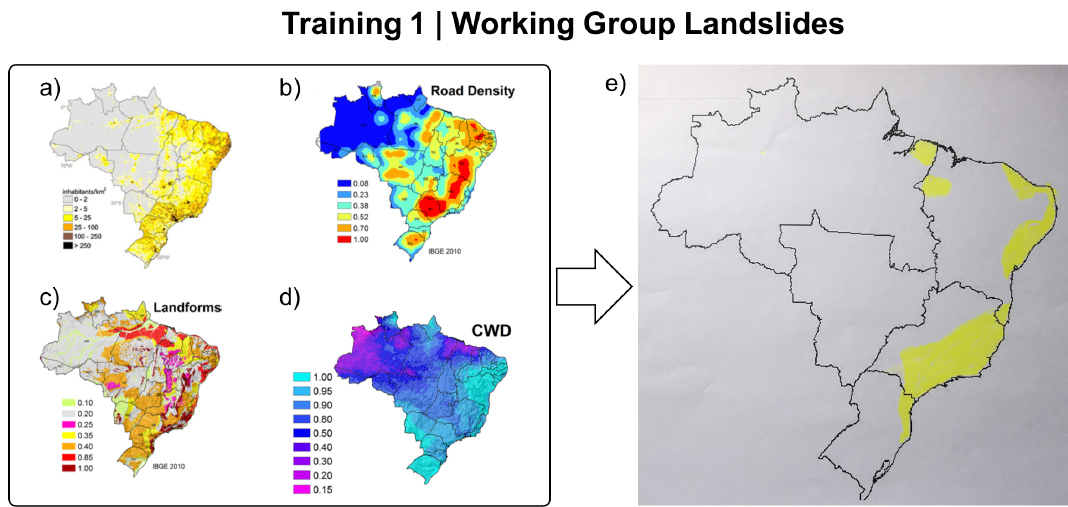
Figure A2. Package of maps used in the first training for mapping climate risk associated with landslides. The maps illustrate (a) Brazilian population density (Torres et al., 2012), (b) road density (Debortoli et al., 2017), (c) landforms (Debortoli et al., 2017), (d) consecutive wet days (CWD; Debortoli et al., 2017), and (e) the climate risk map drawn by the